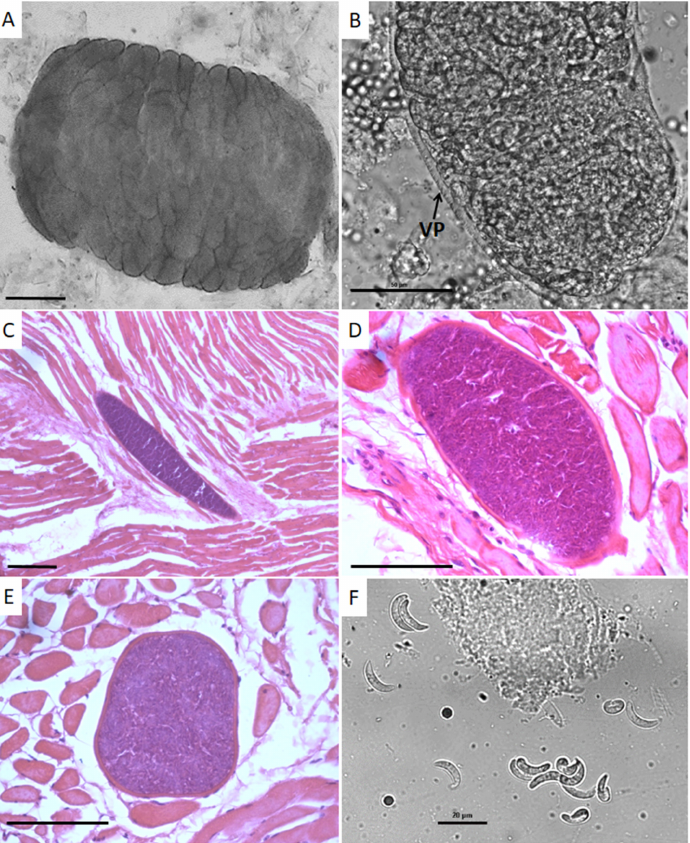
Figure 1. Sarcocystis bertrami in horse tissues observed using light microscopy. ( A ) A highly septated unstained sarcocyst from the tongue with numerous septa. Bar = 100 µm; ( B ) part of an unstained tissue cyst from the tongue with visible villar protrusions. Bar = 50 µm; ( C ) an HE-stained section from the tongue containing an elongated tissue cyst. Bar = 200 µm; ( D ) an elliptical tissue cyst in a tongue section stained by HE. Bar = 100 µm; ( E ) a globular tissue cyst from the tongue stained by HE. Bar = 100 µm; ( F ) free bradyzoites obtained by acid pepsin digestion from a fragment of gluteal muscle. Bar = 20 µm.